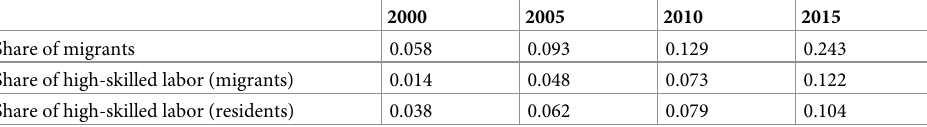
Table 2. Share of migrants and high-skilled labor from 2000 to